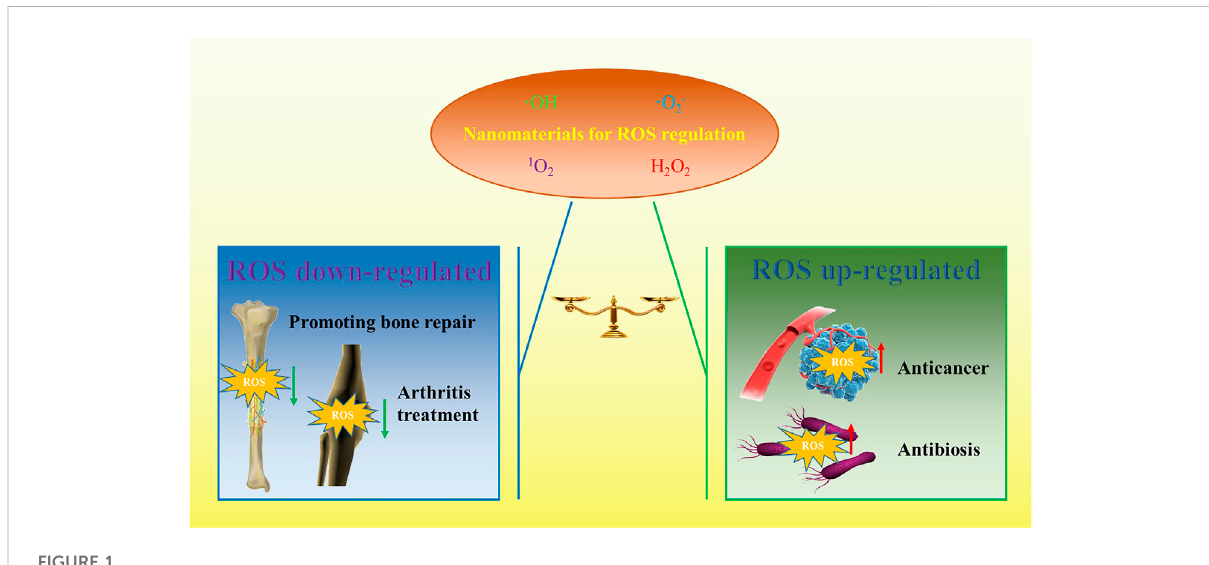
FIGURE 1 Summary of the application direction of nanomaterials in orthopaedic diseases.